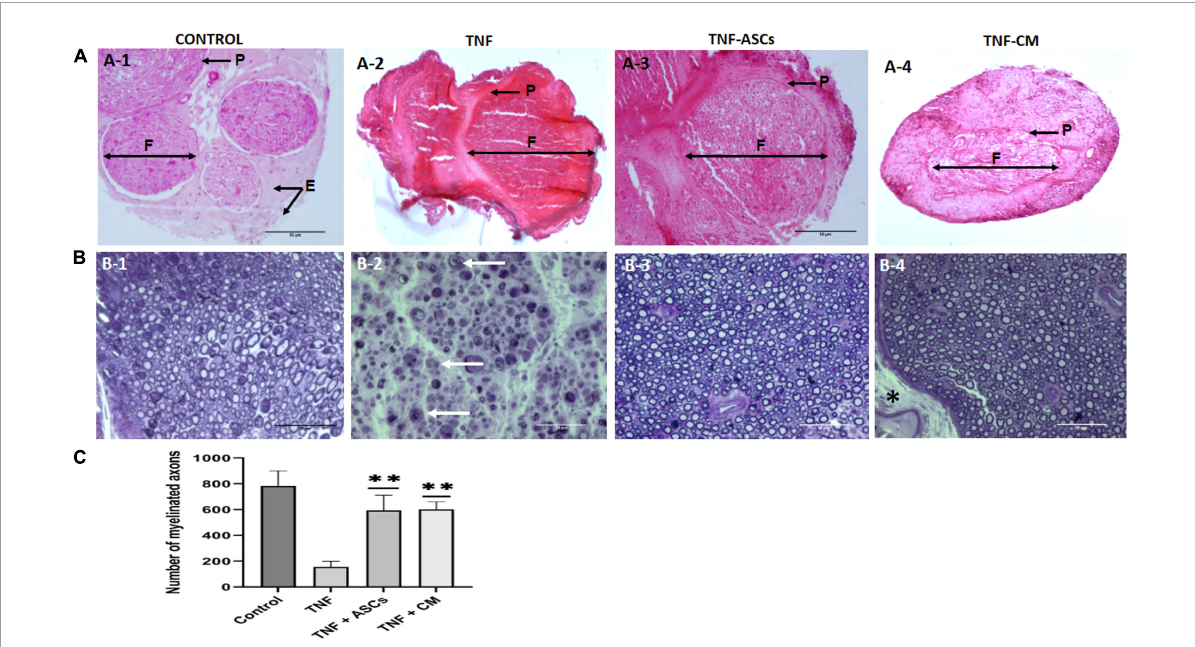
FIGURE3 Rat sciatic nerve Histology. Representative images of hematoxylin-eosin staining (upper images). (A) From panels (A-1–4) tissue from control rats (biomaterial only); tissue from rats given biomaterial containing TNF; tissue from rats given biomaterial containing TNF+ACS; and tissue from rats given biomaterial containing TNF+CM. Images showing the nerve fascicles (F) grouped in bundles surrounded by perineurium (P) and epineurium (E). Scale bar: 20 µ m. (B) Semi-thin slices of transverse sections of rat sciatic nerve stained with toluidine blue (lower images). From panels (B-1–4) normal tissue from the control group; tissue from the TNF-group axons show clear signs of degeneration and there is myelin degradation. Tissue from the ASC and CM groups both show signs of regenerated nerve fibers surrounded by newly formed myelin sheaths. The thick epineurium layer is marked with an asterisk ( ∗ ). White arrows indicate degenerated myelin remnants. Scale bar: 50 µ m. (C) Quantification of number of axons and comparation for all four groups. The results are expressed as the mean ± SD of three independent experiments ∗∗ p ≤